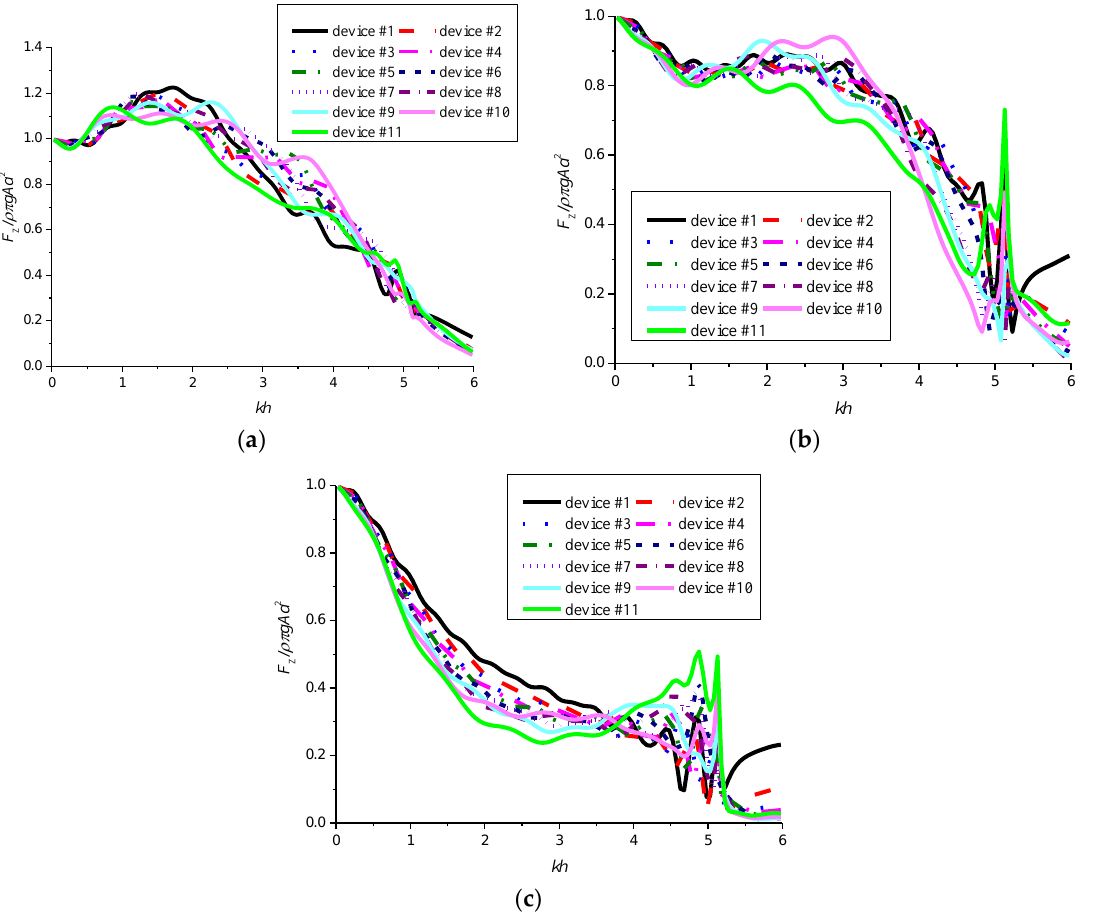
Figure 11. Dimensionless heave wave exciting forces on each WEC device for β = 30° ( a ), 60° ( b ), and 90° ( c ).